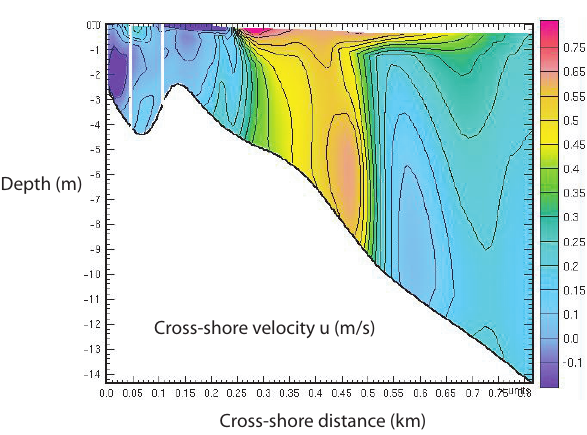
Fig. 17. Vertical section (corresponding to section 3 in Fig. 15) of the cross-shore velocity at the storm